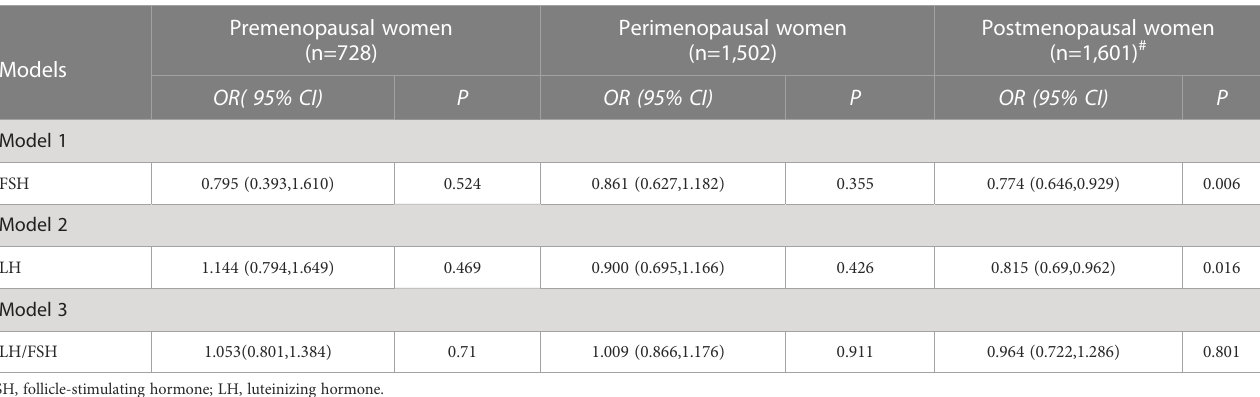
TABLE 3 The associations of FSH, LH, and LH/FSH with the risk of metabolic syndrome ※ .